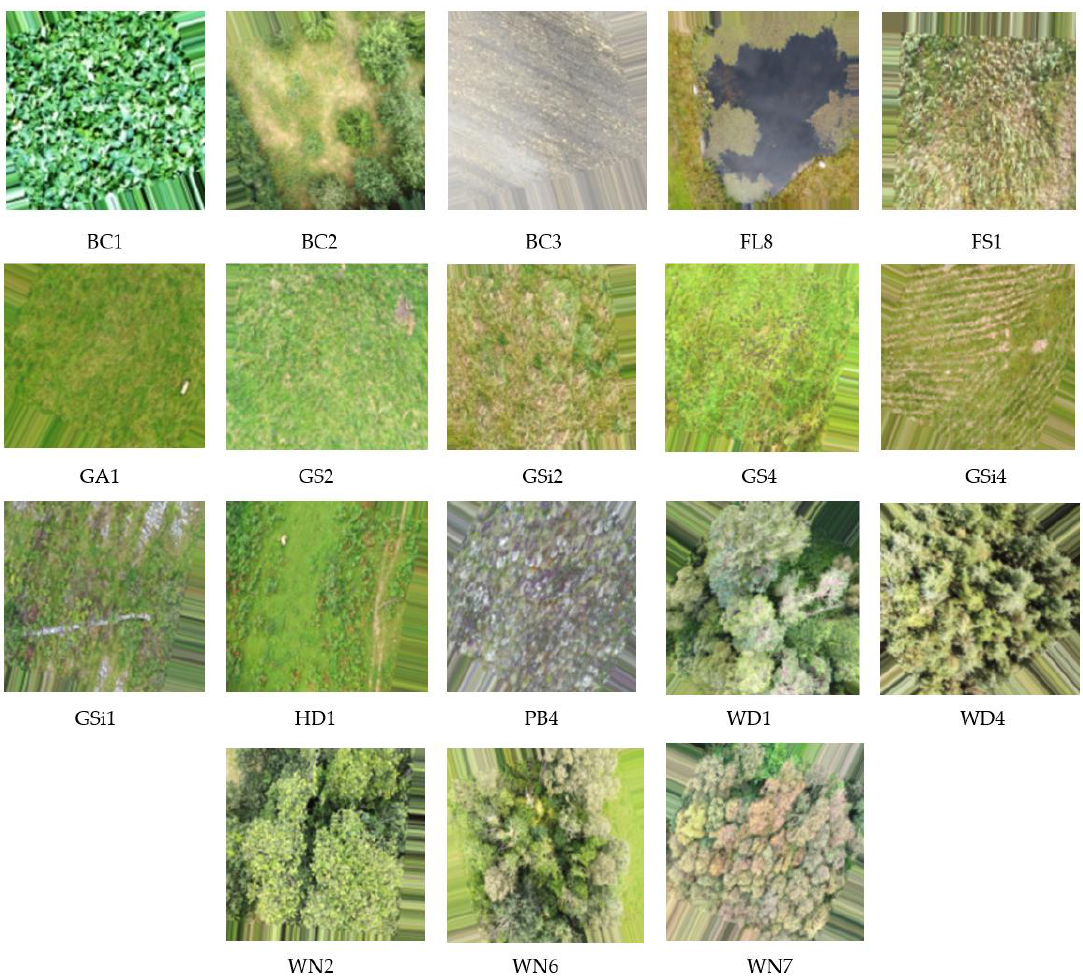
Figure 6. Sample images of 18 different habitats in the dataset (from Figure 2) following transfor- mation using a combination of rotation, flipping, shifting, and